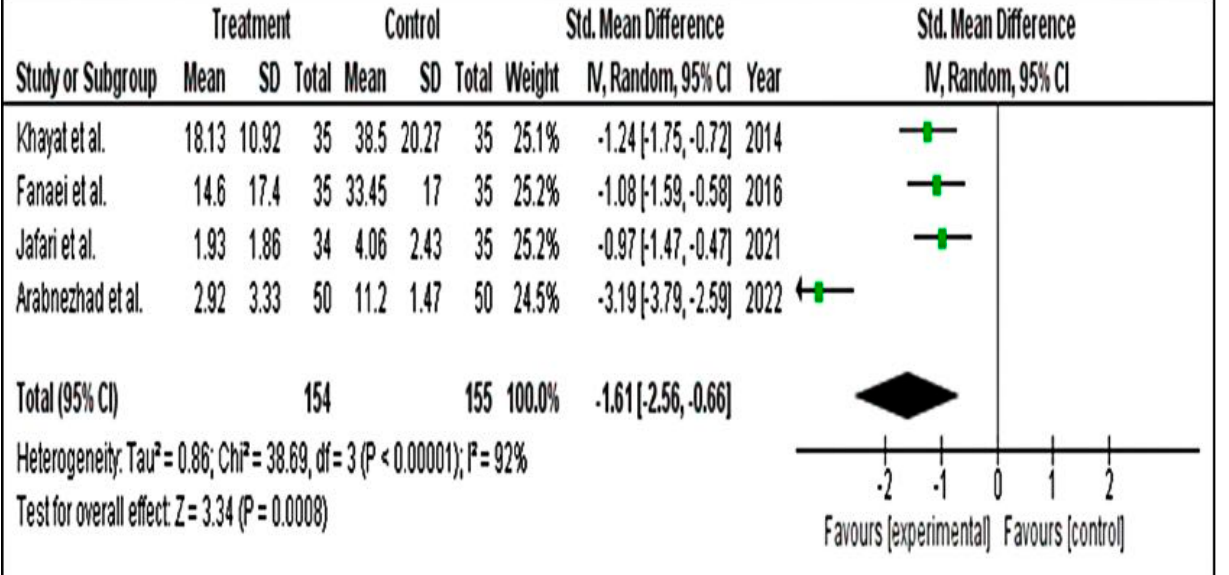
Figure 8. Forest plot for subgroup physical symptoms of PSST scale [1,5,45,51].